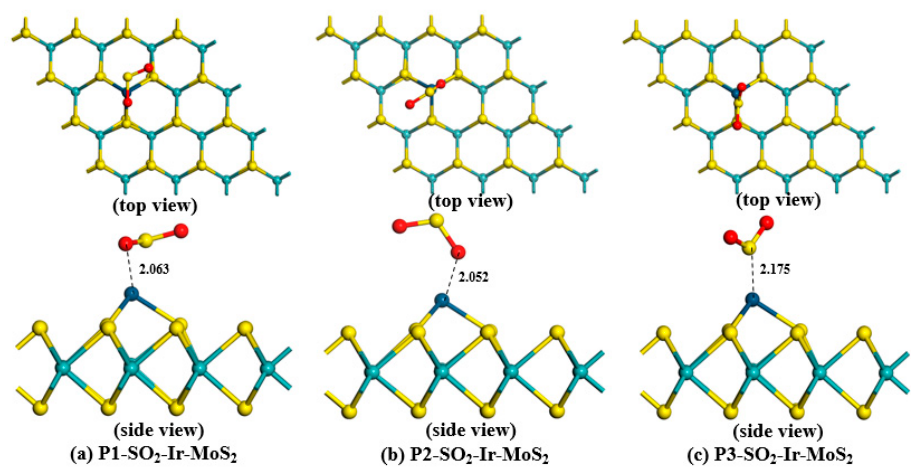
Figure 4. Various optimized configurations of H 2 S-Ir-MoS 2 adsorption systems.